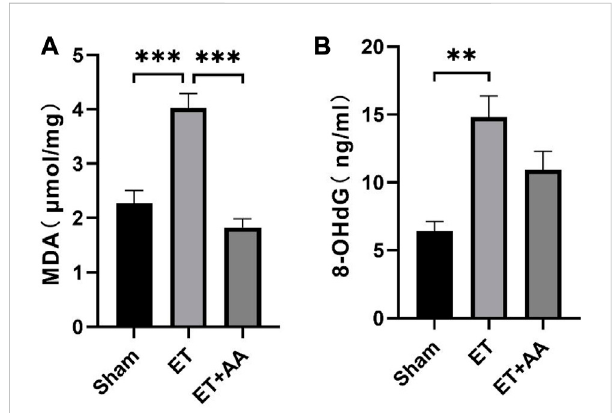
FIGURE 10 Kidney MDA and 8-OHdG levels pre- and post-ET in the sham,